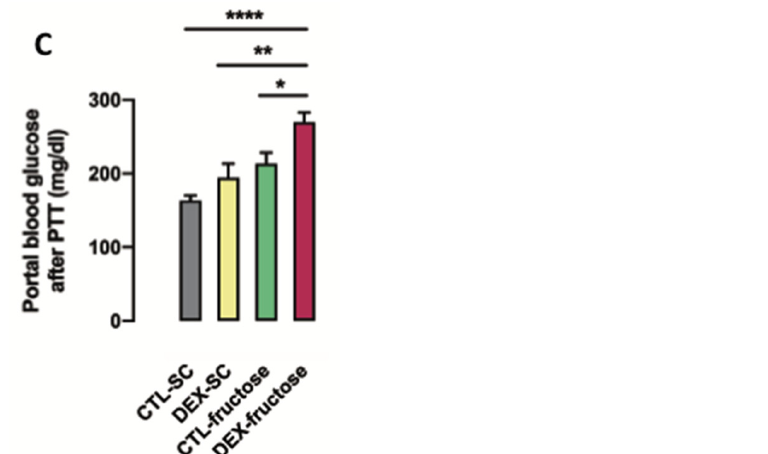
Figure 3. Whole-body and intestinal use of pyruvate as a gluconeogenesis substrate by rats exposed to dexamethasone (DEX) in utero and treated with fructose during adult life. The 40 h fasted rats received an i.p. injection containing sodium pyruvate. The blood from the tail was collected before and 15, 30, 60, and 90 min after intraperitoneal (i.p.) injection for glucose measurements ( A ) and the area under the curve (AUC) was calculated above each individual baseline ( B ). Glucose levels were also measured in portal blood at the end of the pyruvate tolerance test (PTT) ( C ). Results are presented as mean ± standard error of the mean (S.E.M.) * p < 0.05, ** p < 0.01, *** p < 0.001 ( n = 8). Offspring born to control (CTL) mothers that received only standard chow (SC) and tap water during adult life (CTL-SC); offspring born to DEX-treated mothers that received only SC and tap water during adult life (DEX-SC); offspring born to CTL mothers that received SC plus 10% fructose during adult life (CTL-fructose); and offspring born to DEX-treated mothers that received SC plus 10% fructose during adult life (DEX-fructose).